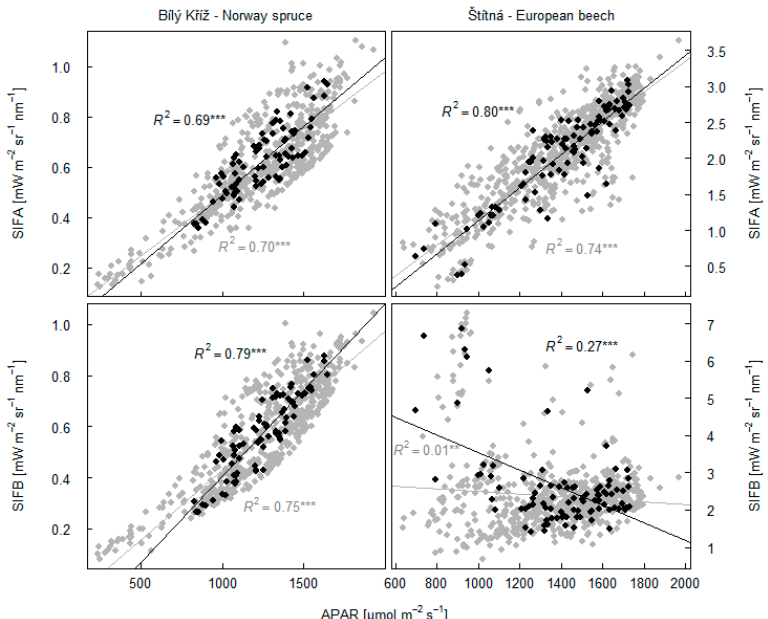
Figure 9. Dependency of fluorescence in O 2 A band (SIFA) and O 2 B band (SIFB) on amount of absorbed photosynthetically active radiation (APAR). Relationships between black points refer to averaged data across 2 h interval at midday on days with almost no clouds. N = 80 for spruce data set and N = 93 for beech data set. Grey points data refer to relationships on selected days between the data in 30 min intervals between 10:00 to 14:00 h. The asterisk indicates statistical significance of the result (*** for p ˂ 0.001, ** for p ˂ 0.01).